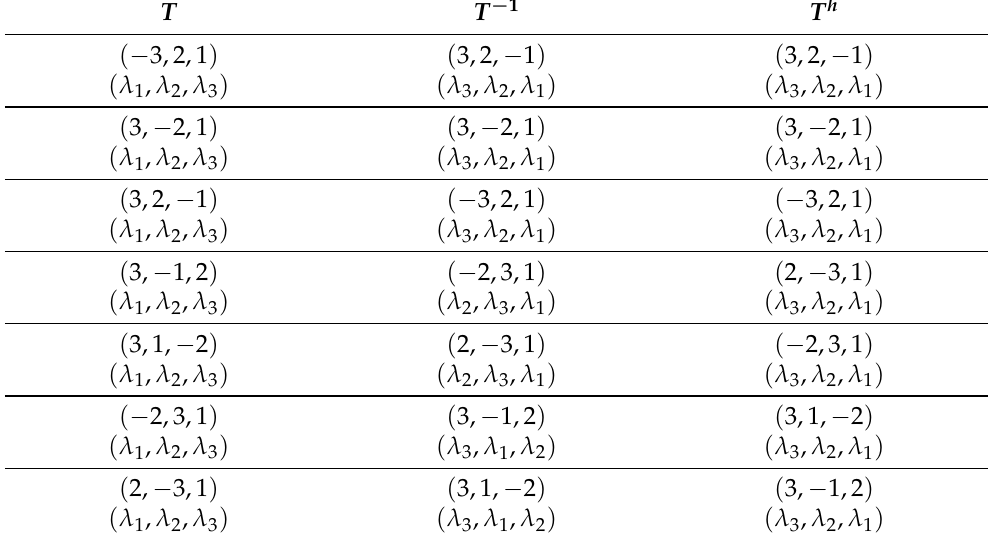
Table 3. 3-IETs with one flip.